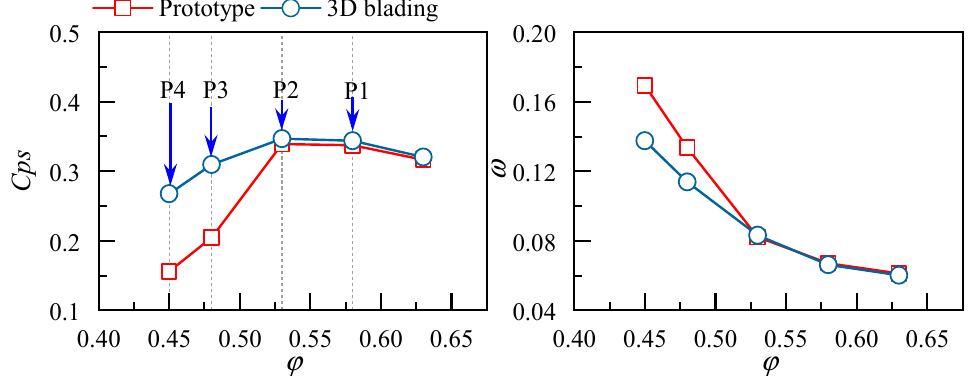
Figure 27. Comparison of pressure rise and loss characteristics of the cantilevered stators.